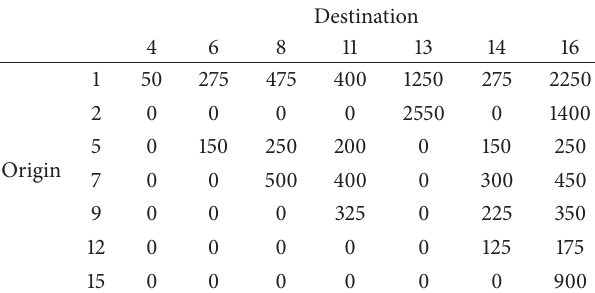
Table 4: Origin-destination demand table in Example 2 (unit: